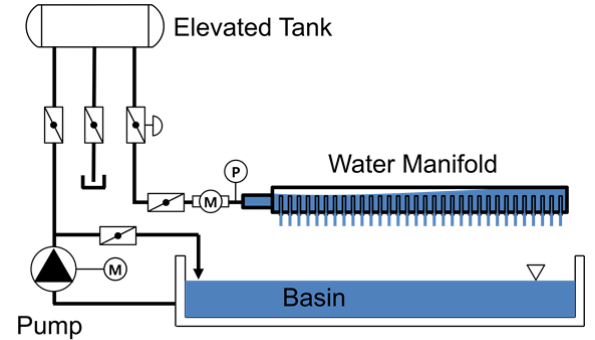
Figure 2. Schematic diagram of the flow system.